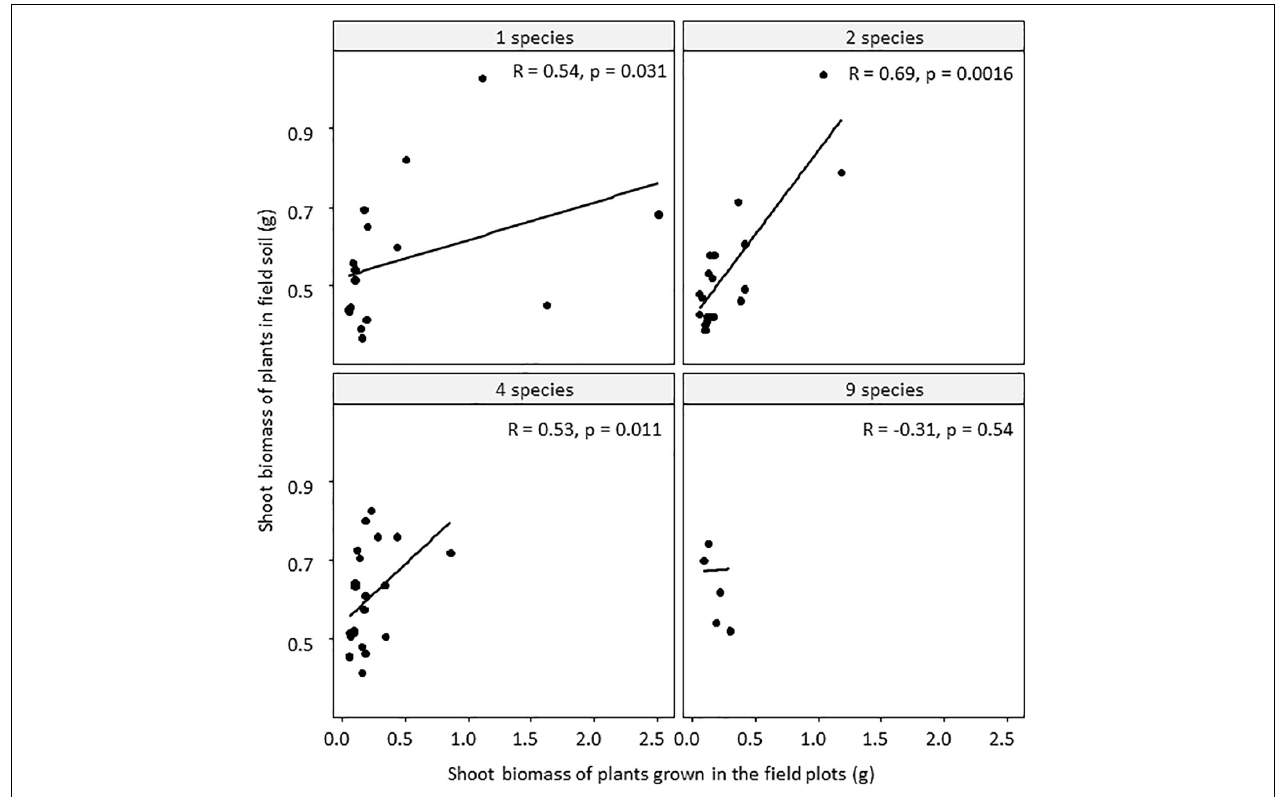
FIGURE 4 | Relationships between shoot biomass of plants grown in the field soil treatment and plants grown in the field in the biodiversity plots, for the different levels of diversity (1, 2, 4, or 9 plant species). R is the Spearman rank correlation coefficient, p -values are based on a Spearman rank correlation test.